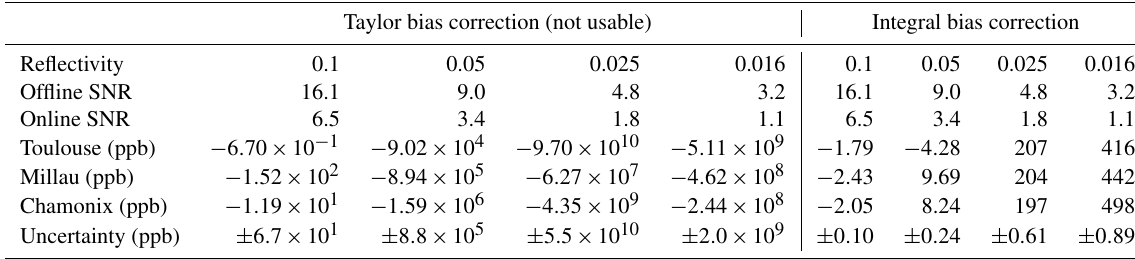
Table 6. Resulting bias (in ppb) for the AVD scheme after noise induced bias correction.